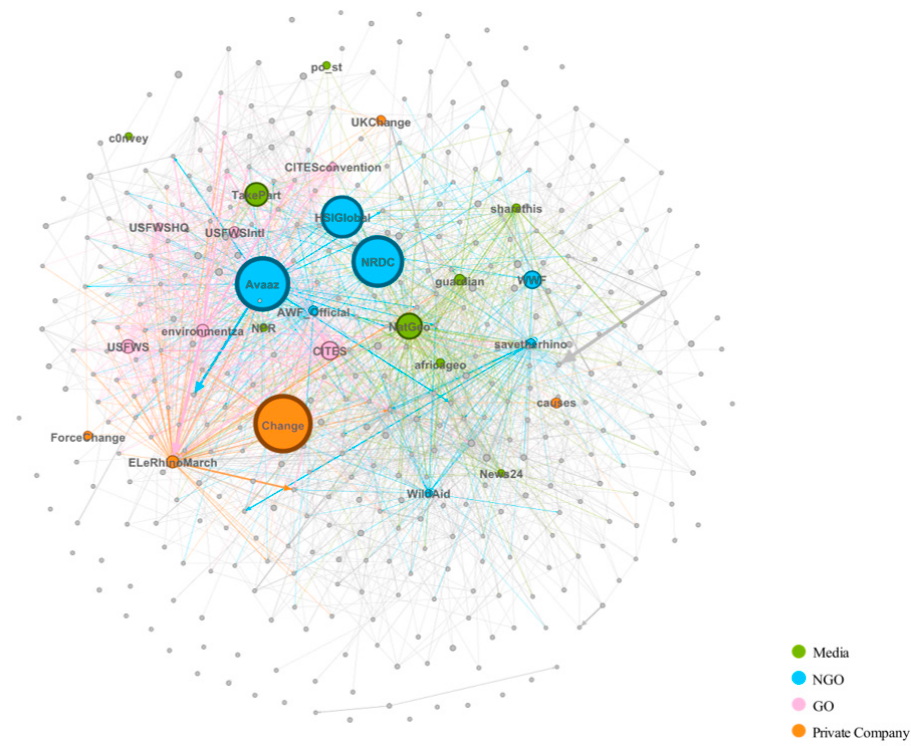
Figure 6. A directed graph of the mentioner–mentionee network.